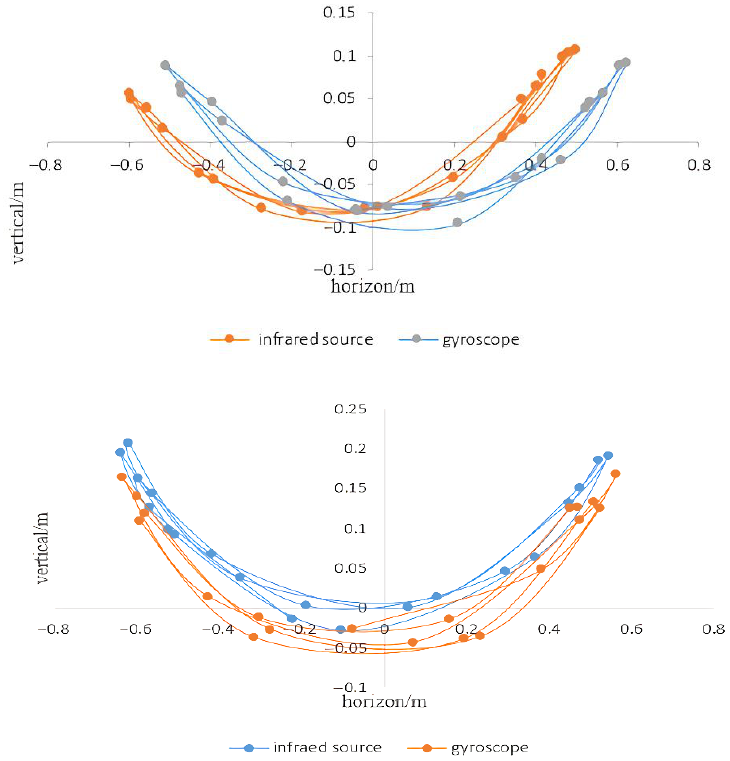
Figure 9. Comparison of experimental trajectories between the two groups.